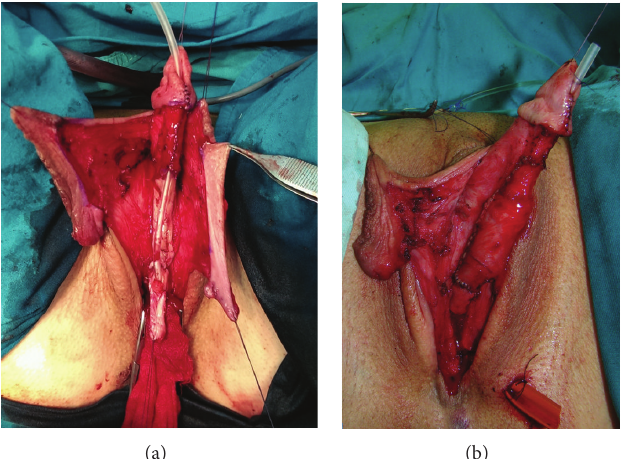
Figure 4: Urethral reconstruction. (a) Flap is harvested from the left labia minora, with preserved vascularization. Previously, buccal mucosa graft is quilted to the ventral side of the corpora. (b) Flap is joined with buccal mucosa graft to create neourethra without tension.